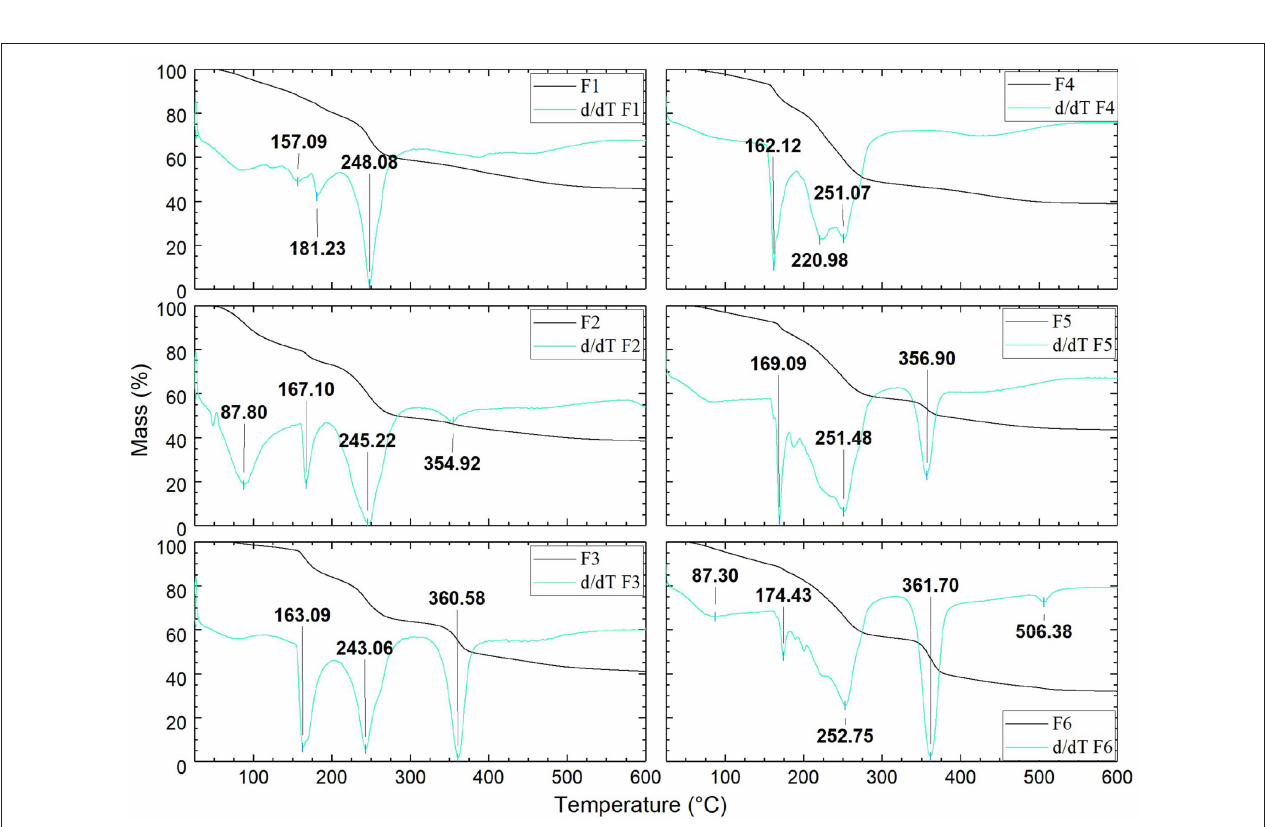
FIGURE 7 | Thermogravimetric Graphs: Formulations F1–F6.